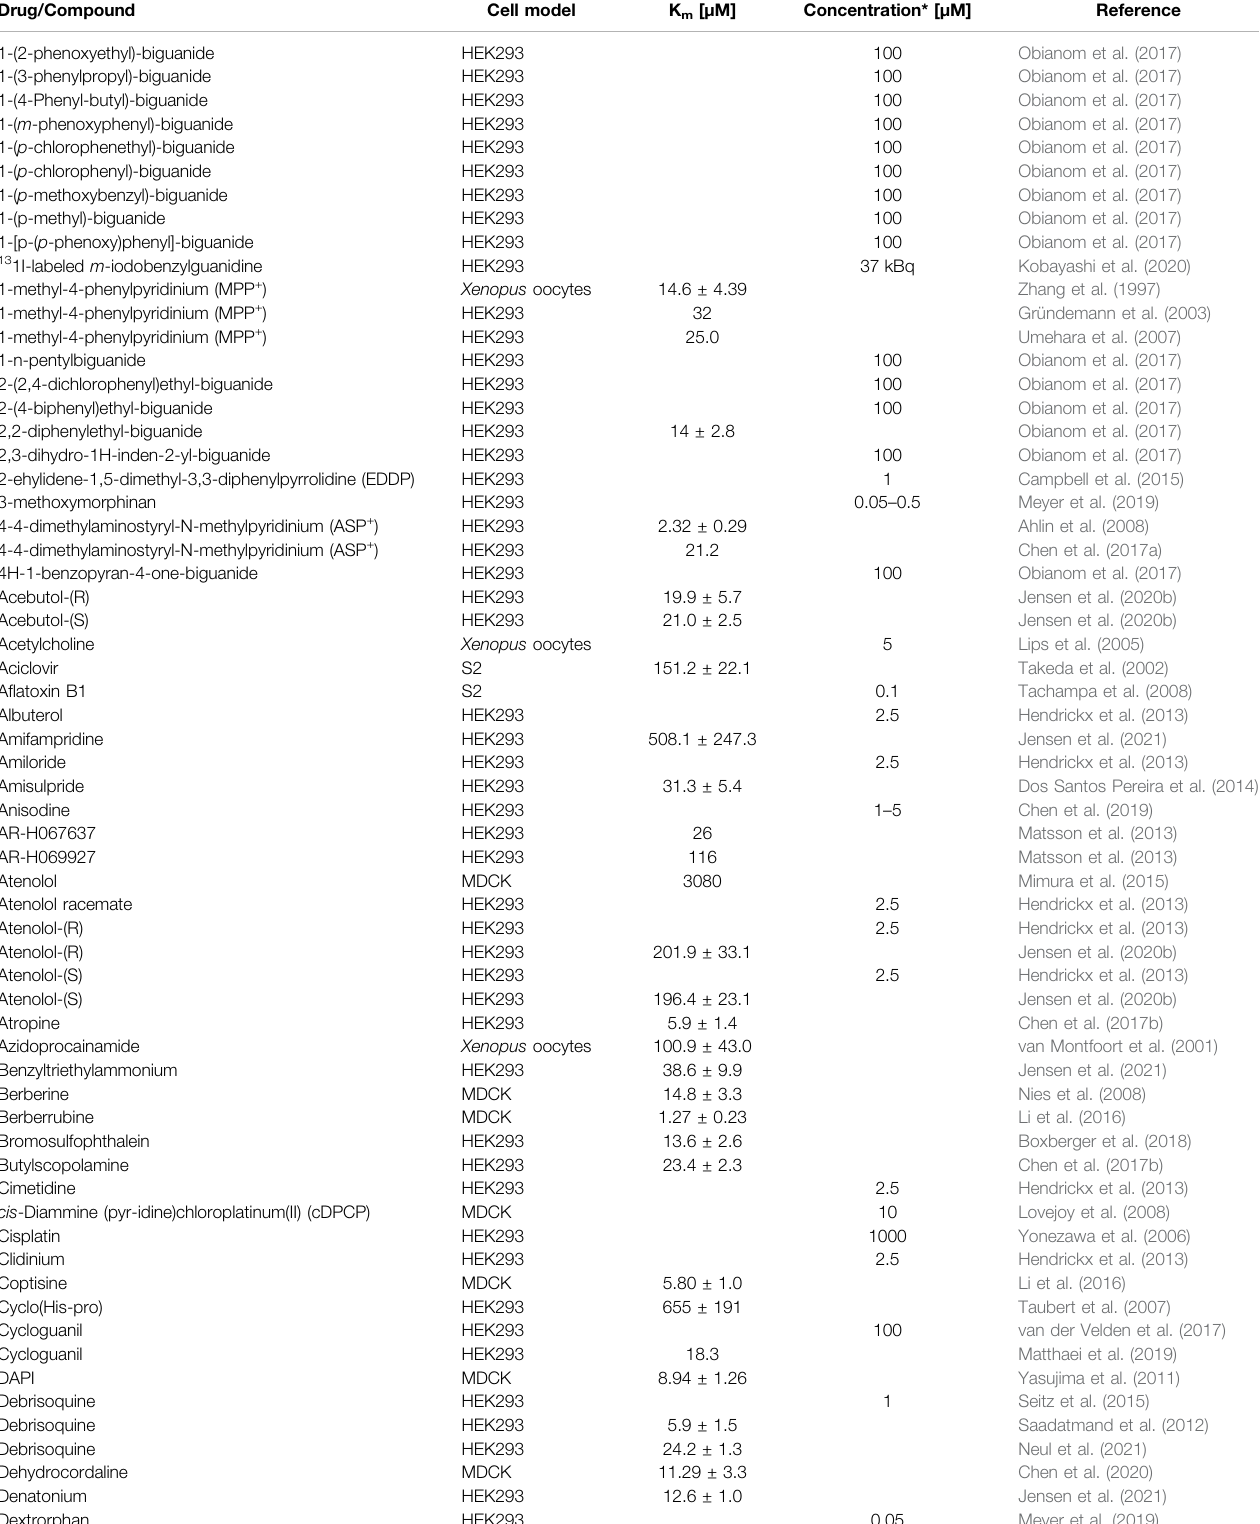
TABLE 1 | Substrates of OCT1 (drugs, drug metabolites, endogenous molecules, chemicals) studied in single-transfected cell